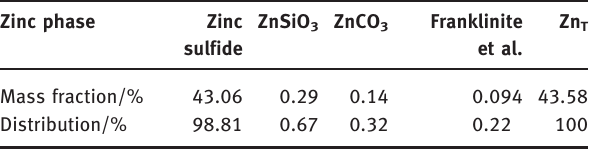
Table 2: Zinc phase distributions of zinc sulfide ores.